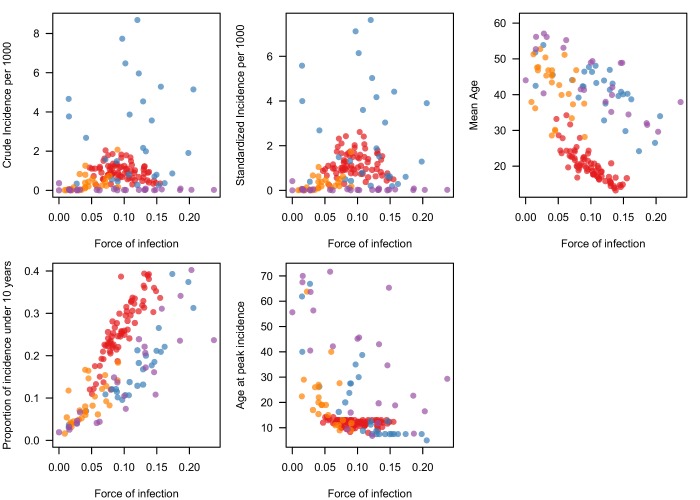
Correlation between estimates of the FOI (derived from age-specific case data) and alternative metrics calculated directly from age-specific incidence data.Red = Thailand, blue = Colombia, purple = Brazil, orange = Mexico.